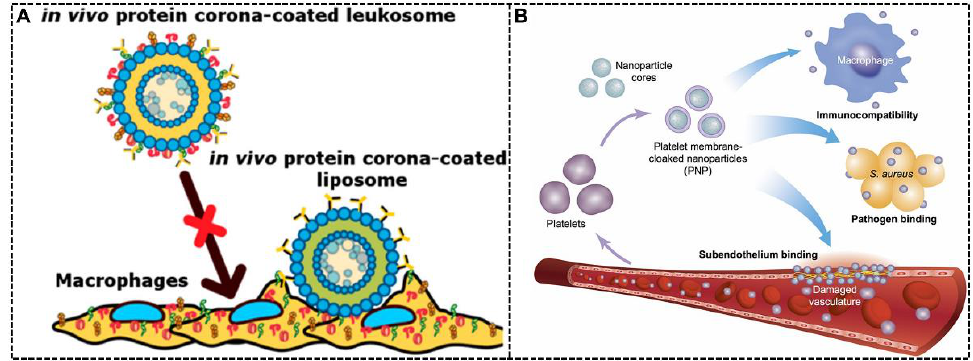
Figure 5. WBC and platelet membrane decoration to harness protein corona. ( A ) Based on the WBC membranes’ decoration, the biomimetic liposomes called leukosomes showed reduced nonspecific interactions and more adsorption of specific proteins over others, resulting in the ability to target inflamed endothelium and avoid clearance by macrophages [73]. Copyright 2017, American Chemical Society. ( B ) Poly(lactic-co-glycolic acid) (PLGA) NPs were decorated with the platelet membrane, showing reduced cellular uptake by macrophage cells and better therapeutic effects [75].